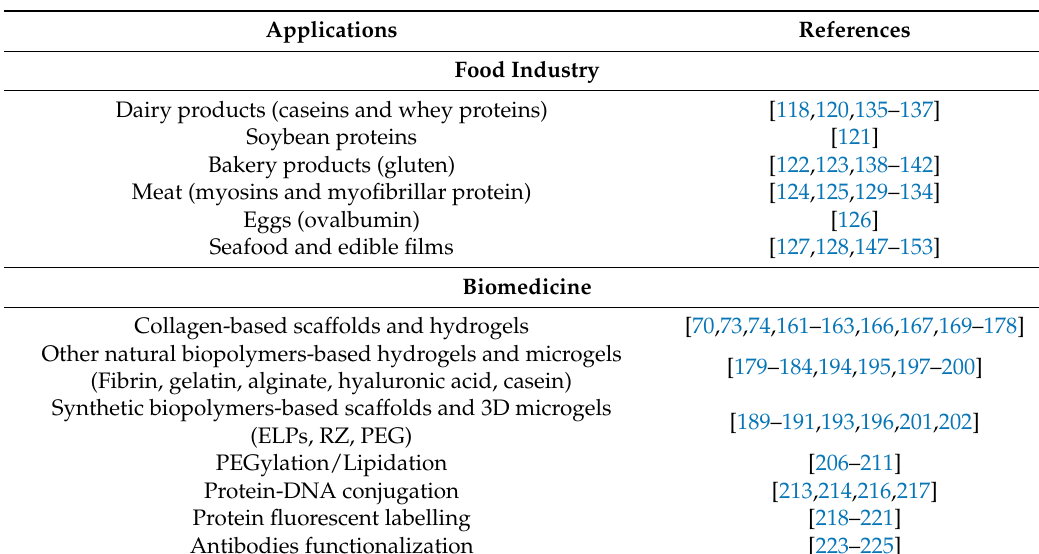
Figure 6. Schematic representation of TG-mediated antibody conjugation. ( a ) TGs can transamidate modified substrates (e.g., aminated or Lys carrying derivatives), such as biotin, fluorophores, or radioisotopes (schematically shown with the yellow “S”), to a carboxamide group of a Q residue on the antibody heavy chain peptide sequence [222,223,225]. ( b ) Branched linkers, conjugated by mTG to the heavy chain of an antibody (e.g., anti-HER2 monoclonal antibody), can be coupled by azide-alkyne cycloaddition to an antimitotic drug (shown as a green “D”) [224]. Table 1. List of applications involving TGs activity.